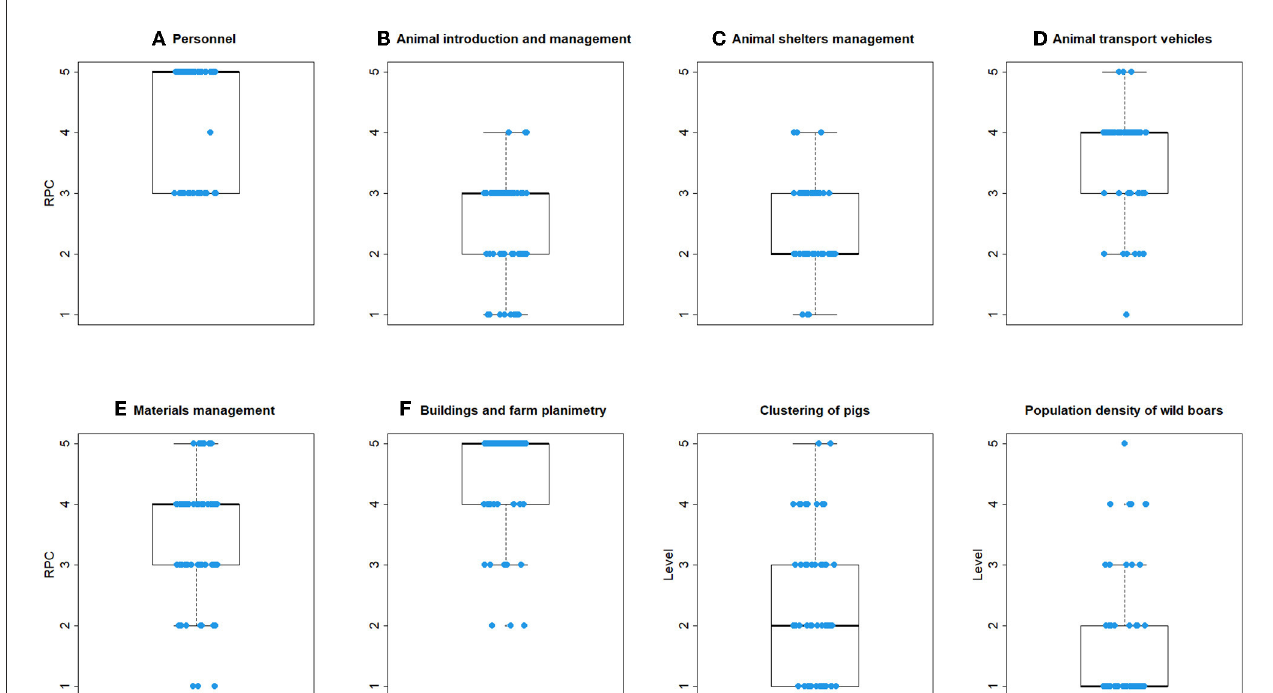
FIGURE4 Boxplot of the distribution of risk priority codes (RPC) for each criterion, obtained by the application of FMEA, local density of pigs, and wild boar population density, estimated in 60 commercial pig farms in Italy. In the boxes, the thick horizontal line represents the median risk priority code; the base and the top of the boxes are the first, and third quartiles, respectively. Whiskers extend to a maximum of 1.5 times the interquartile range. Points represent extreme values. Blue circles represent individual farm’s RPC’s.